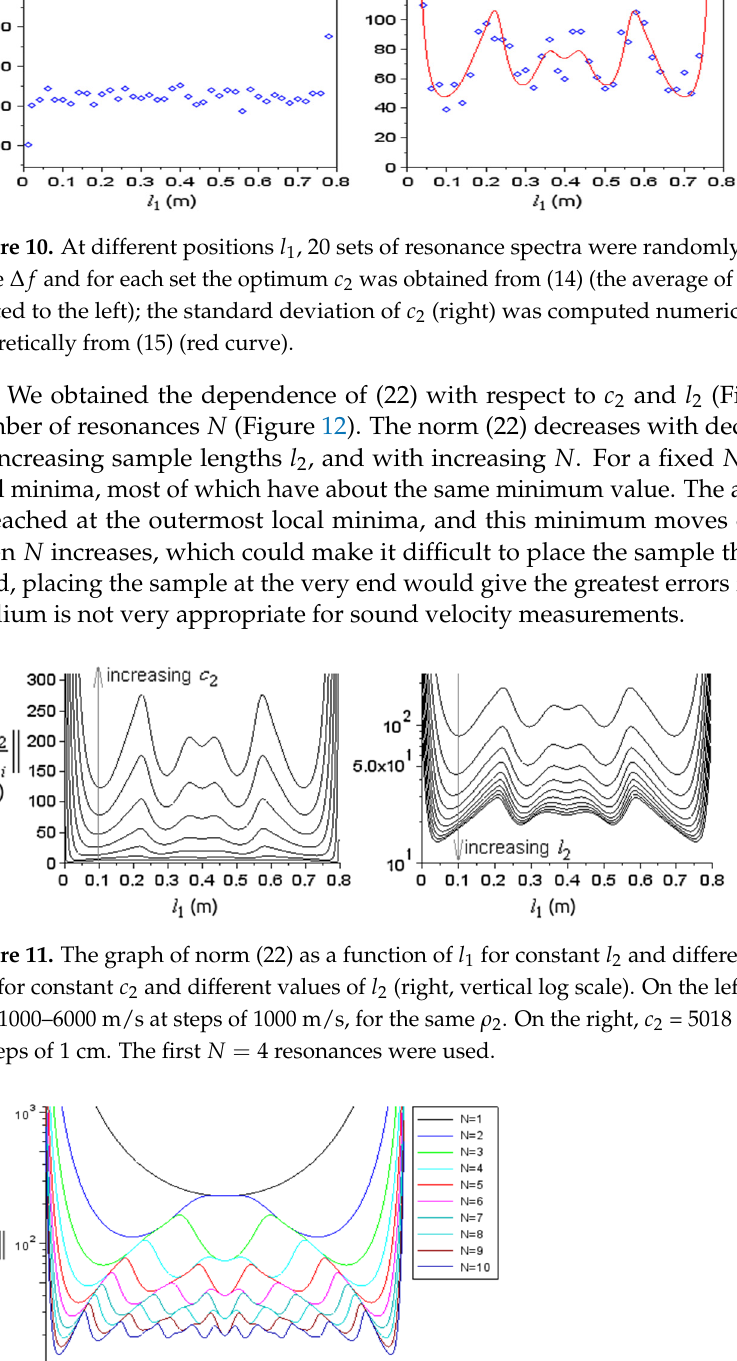
Figure 9. Optimum values of 𝑐 (cid:2870) (blue dots) obtained from (14) for random sets of N = 4 resonanc- es with frequency error ∆𝑓 = 10 Hz , for different positions 𝑙 (cid:2869) of the sample. The red line is (cid:4699) (cid:3105)(cid:3030) (cid:3118) from (22), not to scale. The total length of the medium is constant.